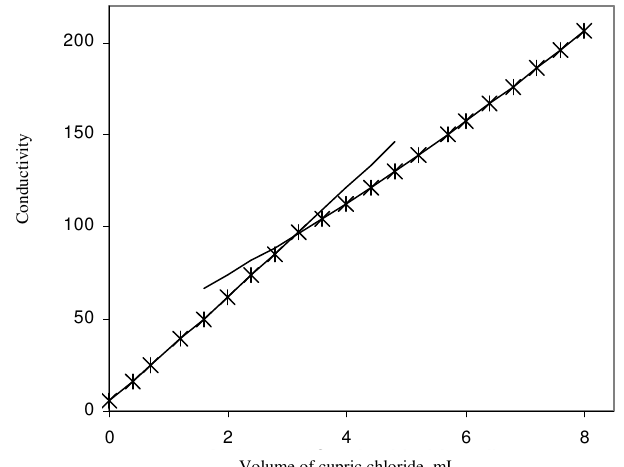
Figure 4. Conductometric titration curve of 11 mg gabapentin vs 10 -2 M cupric chloride The conductance measured before the addition of the titrant (volume of Cu +2 equal zero) is related to the dissociation of the proton of the carboxylic group present in the gabapentin molecule. Up to the equivalence point, the titration involves the gradual substitution of the protons of the gabapentin molecule by cations of Cu +2 . This increase of the conductance is because the mobility of the ion H + is larger than that of ion Cu +2 , causing an increase in the slope of the conductometric curve (first branch of the curve). After the equivalence point, the measured conductance is the sum of the Cu +2 and Cl - present in the solution. As the sum of the mobilities of those ions is smaller than that of the H + cation, there is a decrease in the slope of the second section of the titration curve. The equivalence point is defined as the point of intersection of the two straight